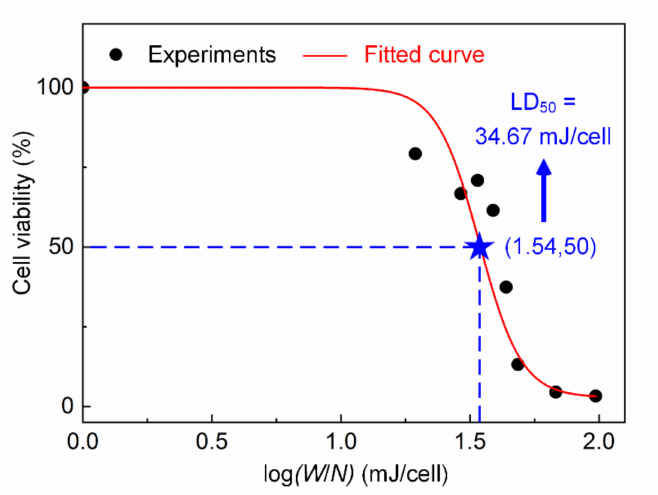
Figure 6. S-shaped curve of the cell viability versus the logarithmic value of ( W / N